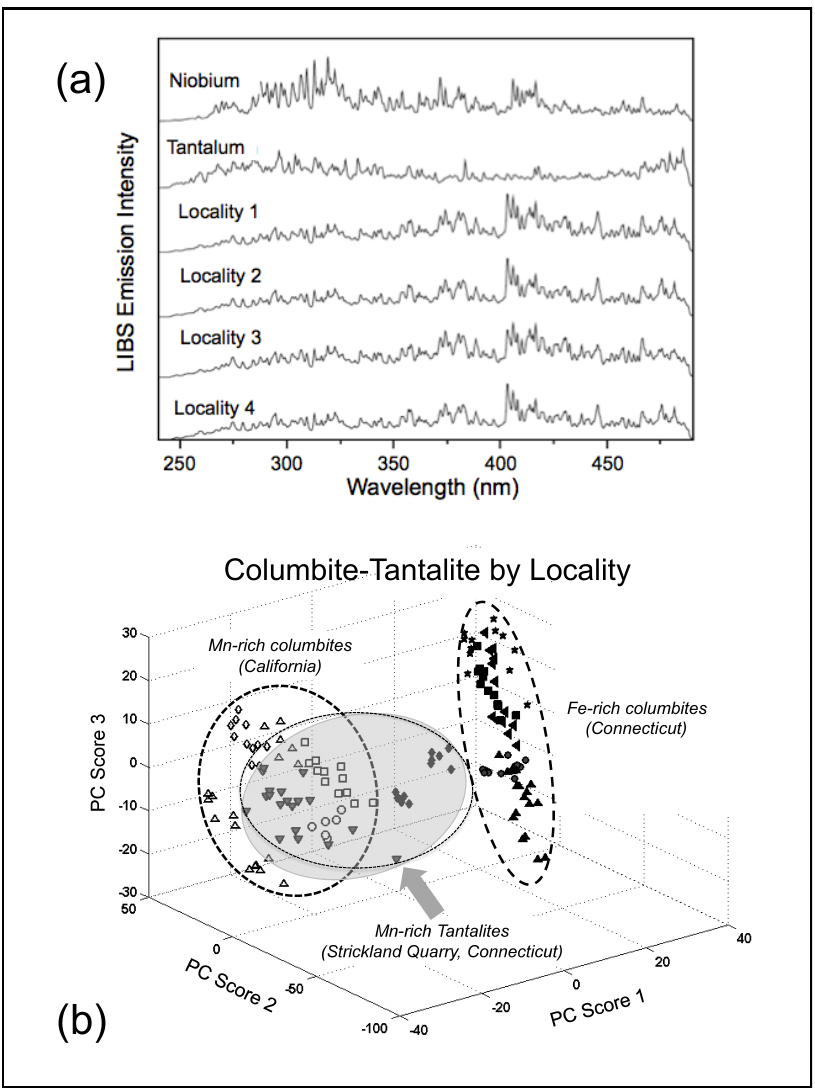
Figure 7. ( a ) LIBS spectra from 250–490 nm of pure niobium and tantalum, together with representative spectra of columbite–tantalite samples from (1) the Starrett pegmatite in southern Maine, (2) the Pack Rat pegmatite in San Diego County, California, (3) the Moose pegmatite in the east–central Northwest Territories, Canada, and (4) the BeeBee pegmatite in San Diego County, California. ( b ) PCA score plot for columbite–tantalite samples from LCT (Li, Cs, and Ta; see text) pegmatite locations at Branchville, Glastonbury, Haddam, Middletown, Portland, and the Strickland Quarry in Connecticut and mines at El Molino, Ingram, Katerina, and Olla in California (modified from Harmon et al. [79]). See text for